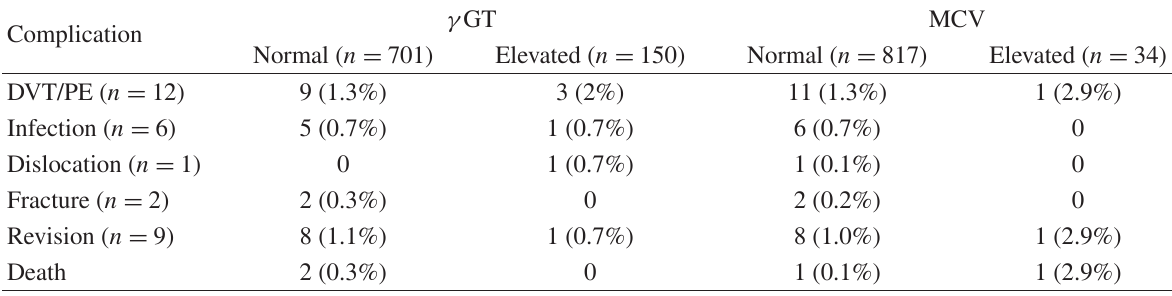
TABLE 3: Complications in patients with normal and elevated